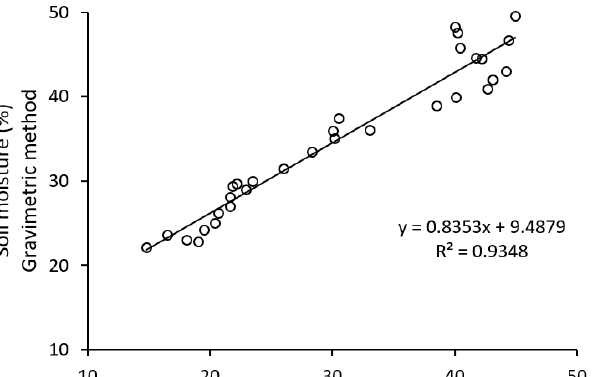
Figure 4. Relationship between soil volumetric moisture on dry basis determined by the gravimetric method and readings obtained in a Falker ® Hidrofarm sensor.